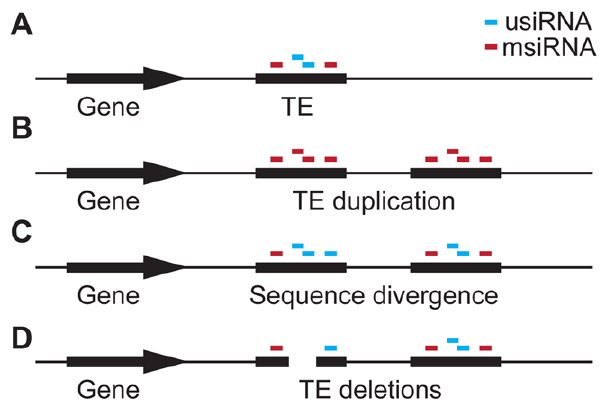
Figure 7. Hypothesis for the role of siRNA–targeting in TE evolution. (a) A gene with an adjacent TE targeted by siRNAs that are either unique to this TE (usiRNAs) or that are shared with multiple locations in the genome (msiRNAs). (b) Duplication of the TE causes all usiRNAs to become msiRNAs. (c) Sequence divergence between the duplicated TEs, e.g. through deamination of methyl-cytosines, which causes C:T transition mutations. As a consequence, msiRNAs are converted to usiRNAs again. (d) TE regions that are enriched for siRNAs, especially usiRNAs, are deleted, reducing the effect of the TE on adjacent